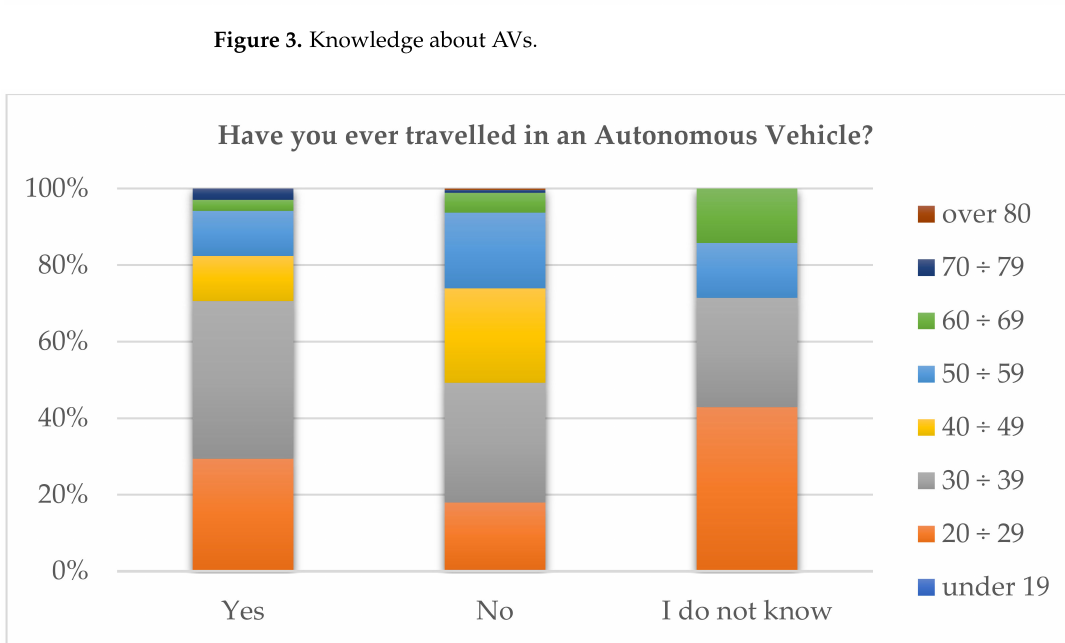
Figure 4. Experience with